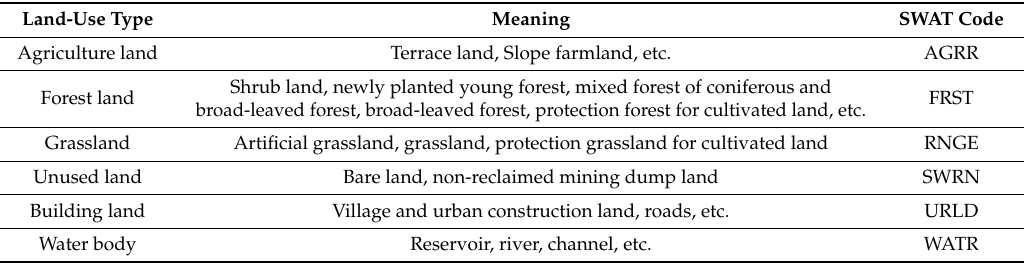
Table 2. The classification of land use types in the upper Sang-kan (USK) river